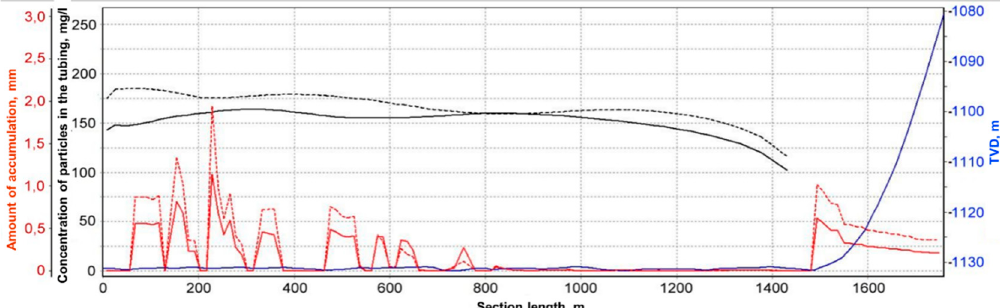
Figure 4. Quasi-steady recovery of particles with diameter of 0.045 mm at rate of 200 m 3 /d: well geometry from toe to pump inlet (blue line), particle concentration in the flow in tubing (black lines), and accumulation of “pillow” from particles (red lines) at different moments in time: solid lines—7 h; dashed lines—14 h.